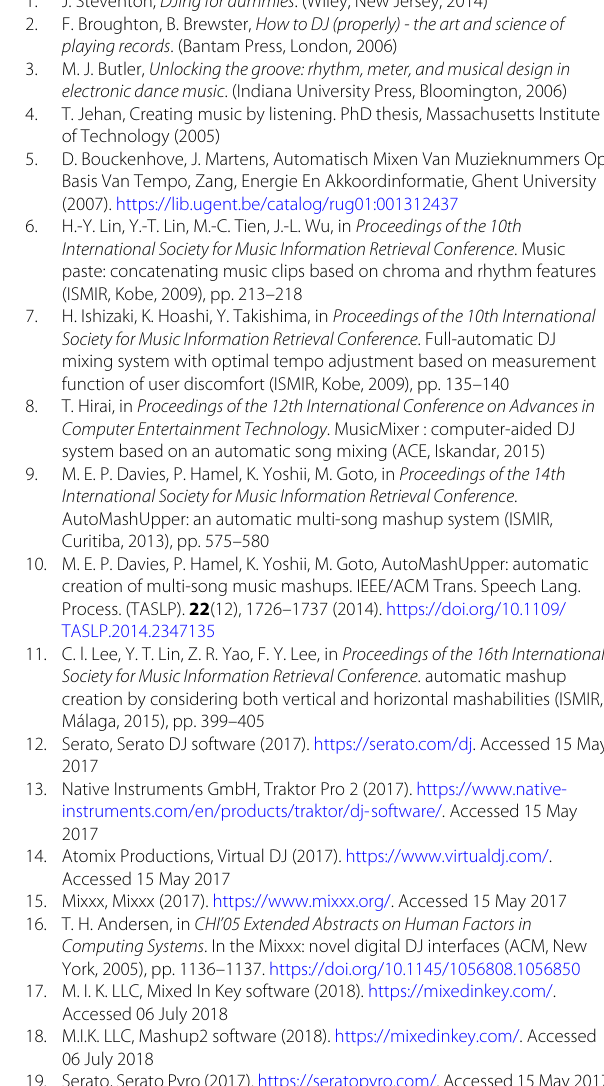
Additional file 1: Table S1: Tracklist of the training set (117 songs). Table S2: Tracklist of the test set (43 songs). Table S3: Tracklist of the additional test set (220 songs). (PDF 35